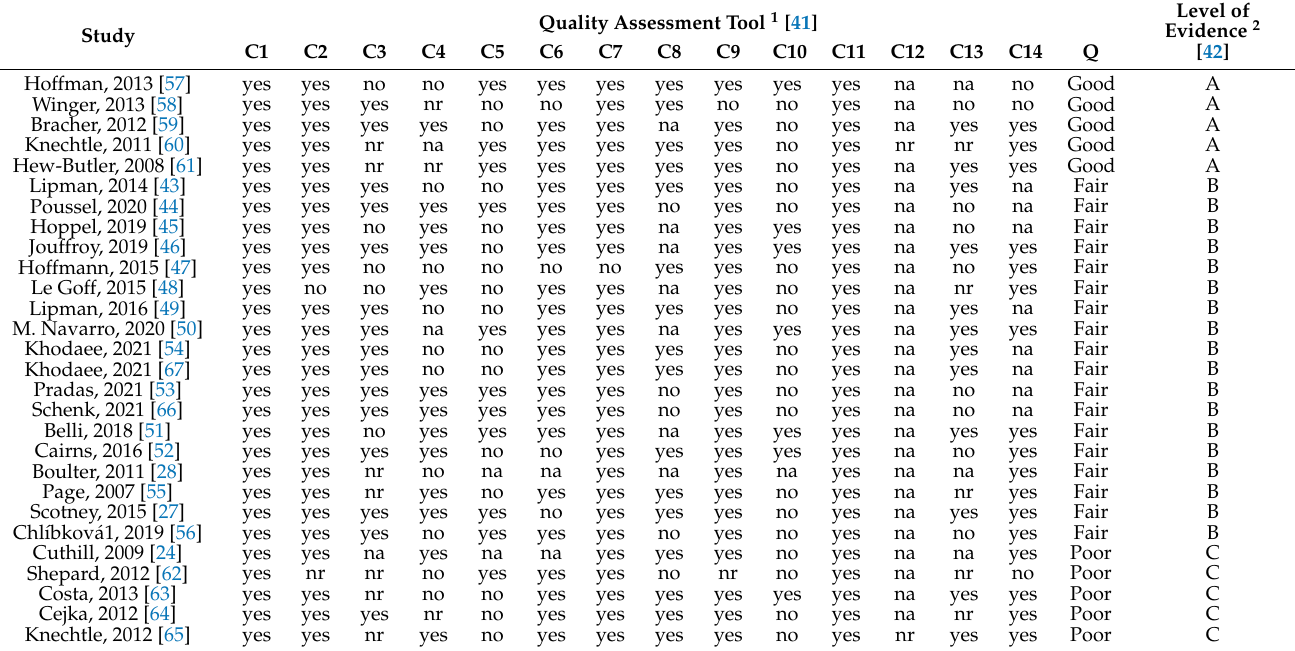
Table 6. Methodological quality assessment of included studies using two assessment